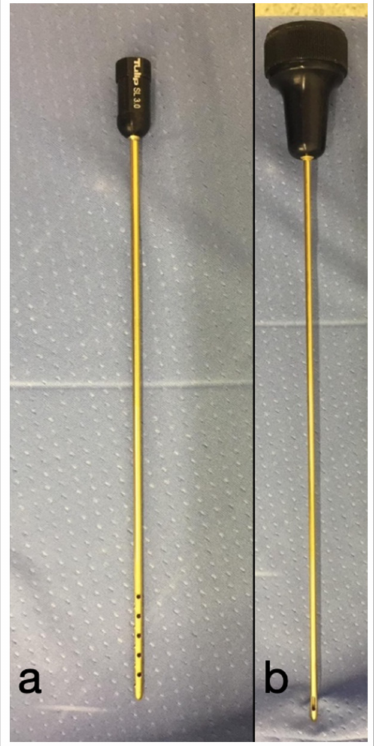
Figure 1. ( a ) The 2.8 mm blunt infiltration cannula and ( b ) 3.8 mm blunt liposuction cannula.